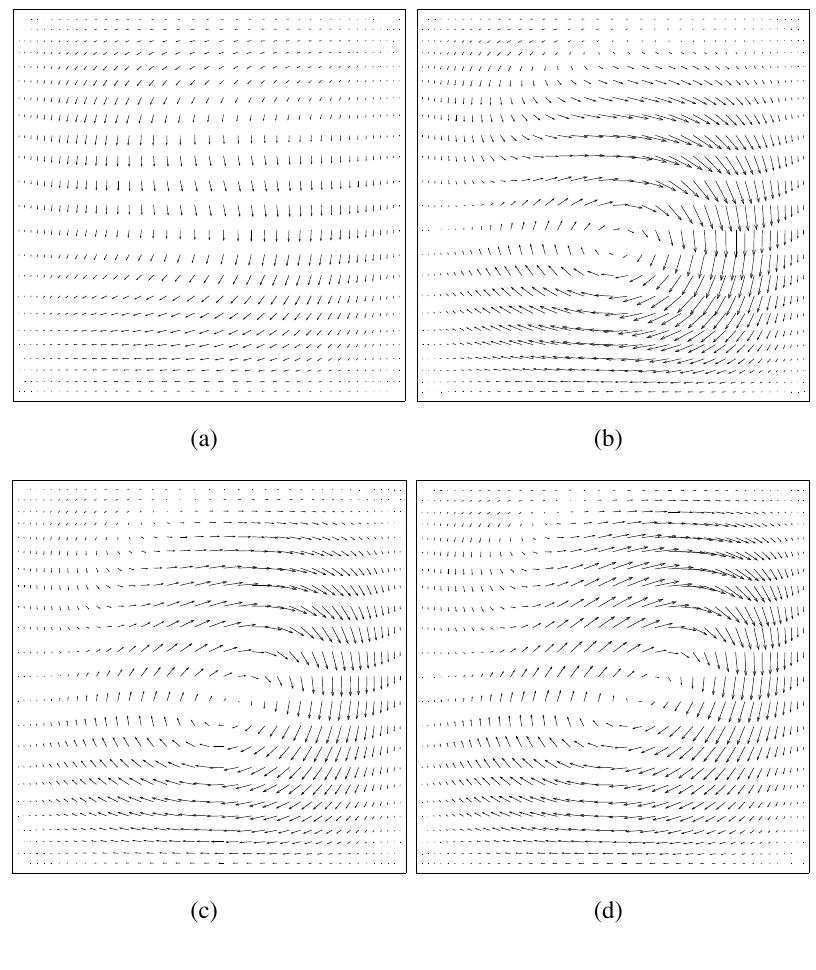
Figure 4. Cross-sectional velocity vectors at z = 0 . 25 L , where L is the length of one geometric period of the channel with α = 1 and β = 1 / 3 . ( a ) Re = 10 , ( b ) Re = 30 , ( c ) Re = 50 and ( d ) Re = 70